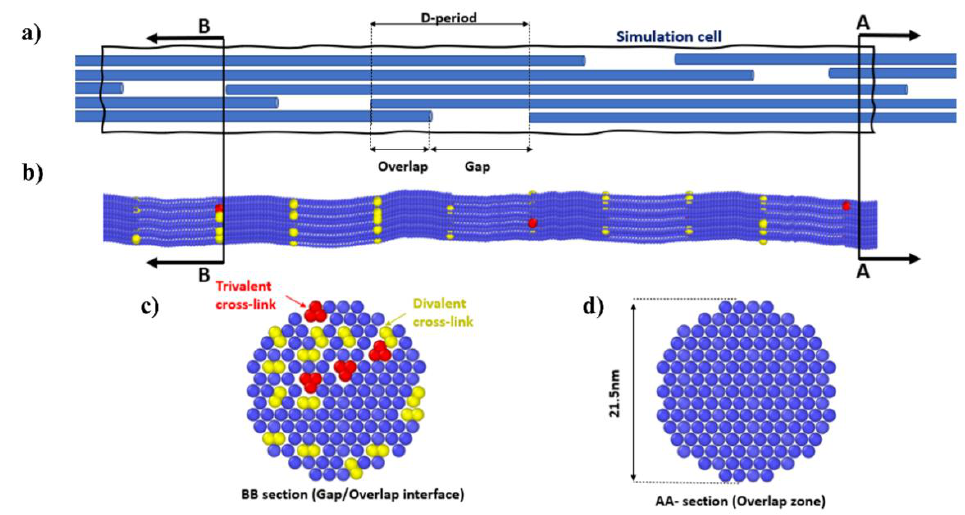
Figure 1. The collagen fibril coarse-grained model. ( a ) Schematic view of the hierarchical structure of the simulation cell. ( b ) Three-dimensional coarse-grained model of a collagen fibril. ( c ) Divalent and trivalent crosslinks in the coarse-grained model. ( d ) Cross-section of the collagen fibril.